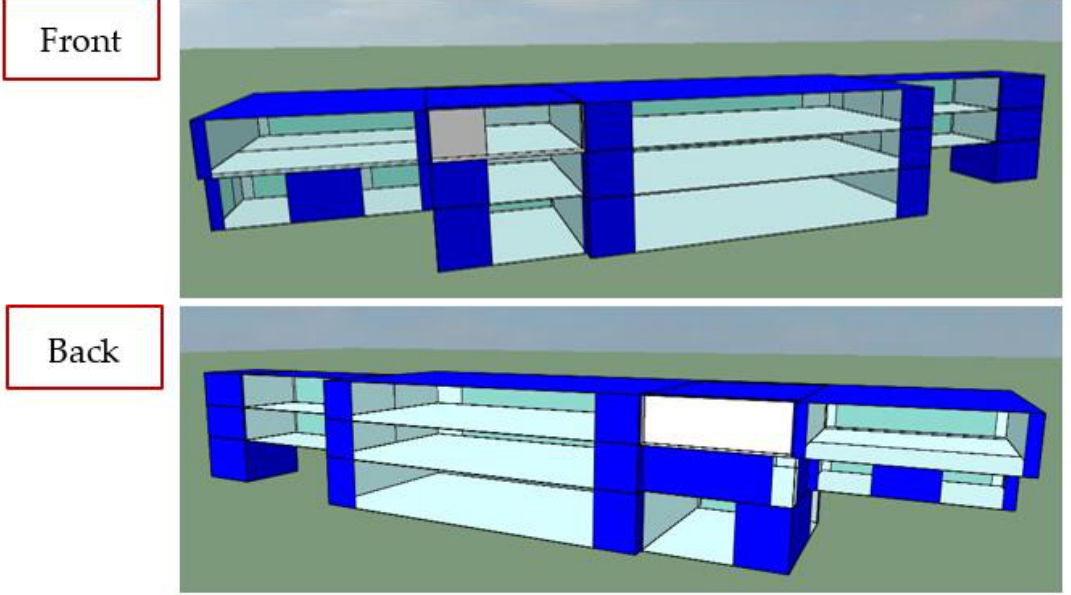
Figure 7. Front and back view of created model of the case study building.